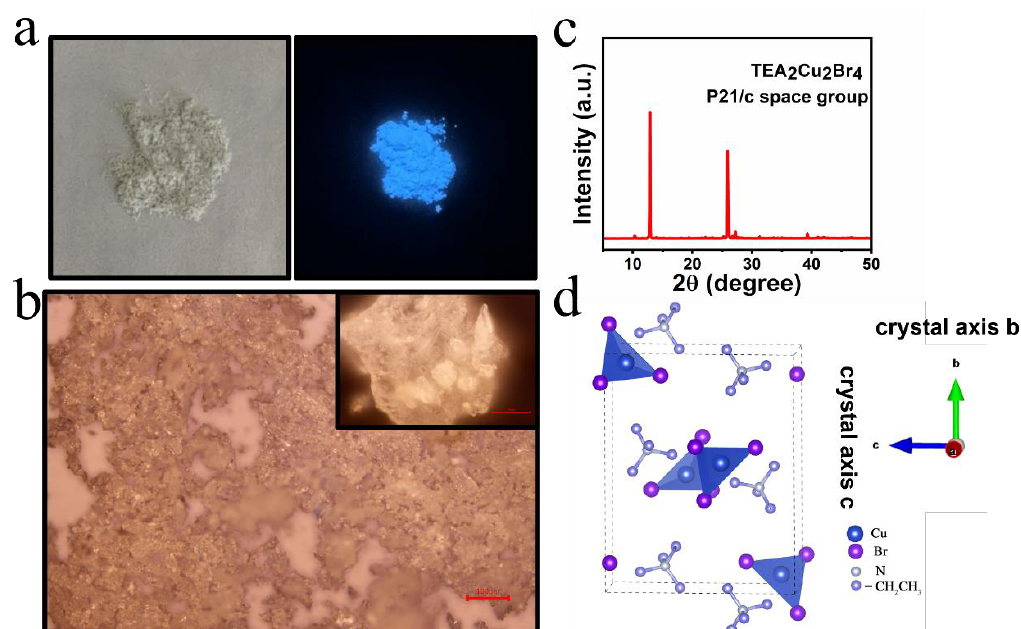
Figure 2. Morphology and crystalline structure of TEA 2 Cu 2 Br 4 crystals. ( a ) Pictures of TEA 2 Cu 2 Br 4 crystals in ambient light (left) and under UV illumination (right). ( b ) Optical microscopy images of TEA 2 Cu 2 Br 4 powder. ( c ) XRD pattern of TEA 2 Cu 2 Br 4 crystals. ( d ) Schematics of crystal structure of TEA 2 Cu 2 Br 4.